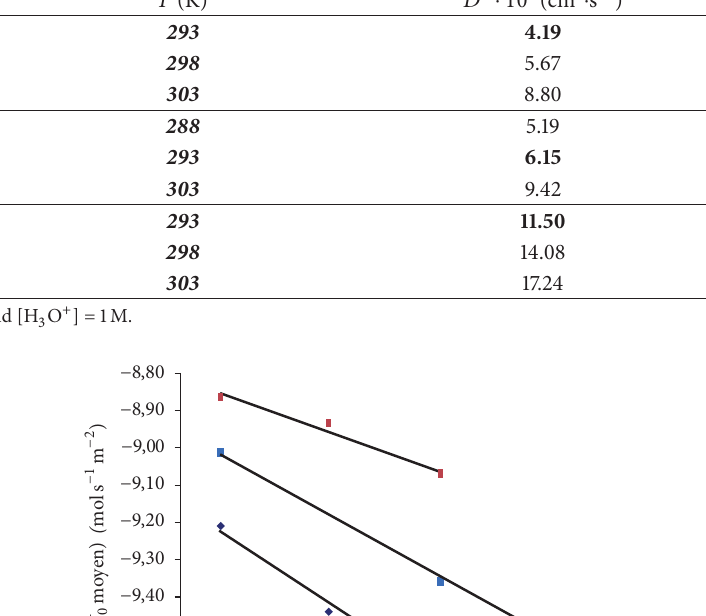
Table 5: Temperature factor influence on the values of 𝐾 Extractive agent